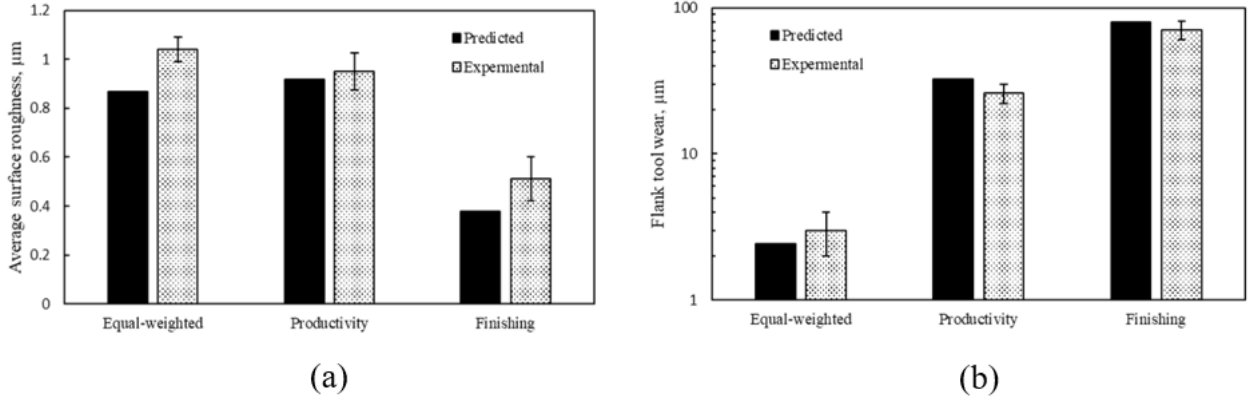
Figure 11. Experimental validation of the results of the optimized scenario; ( a ) Average surface roughness and ( b ) Flank tool wear.